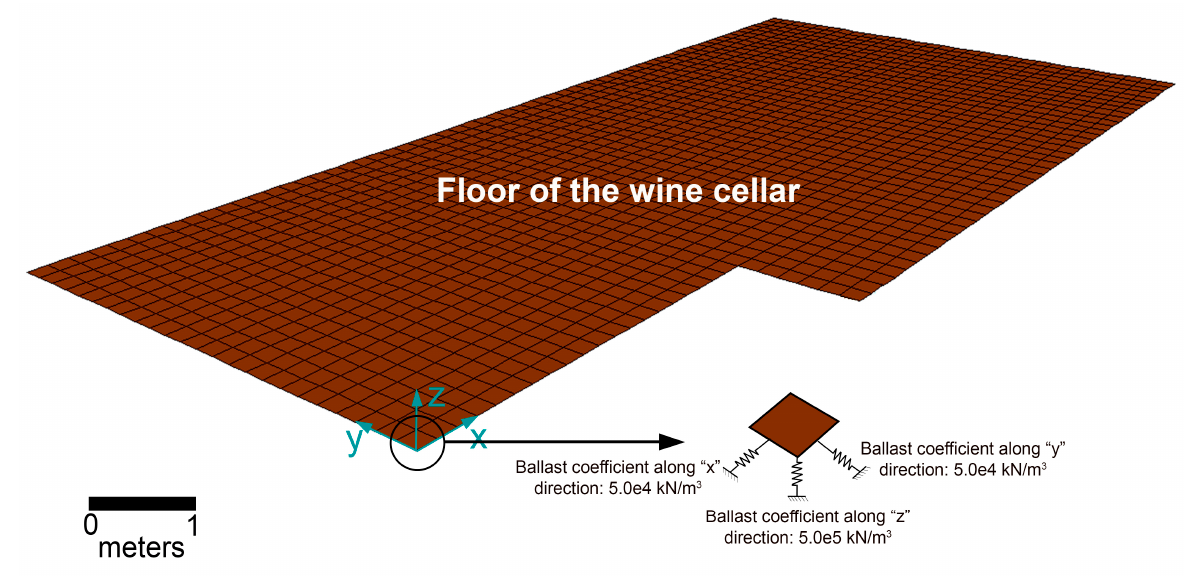
Figure 3. Boundary conditions at the floor of the wine